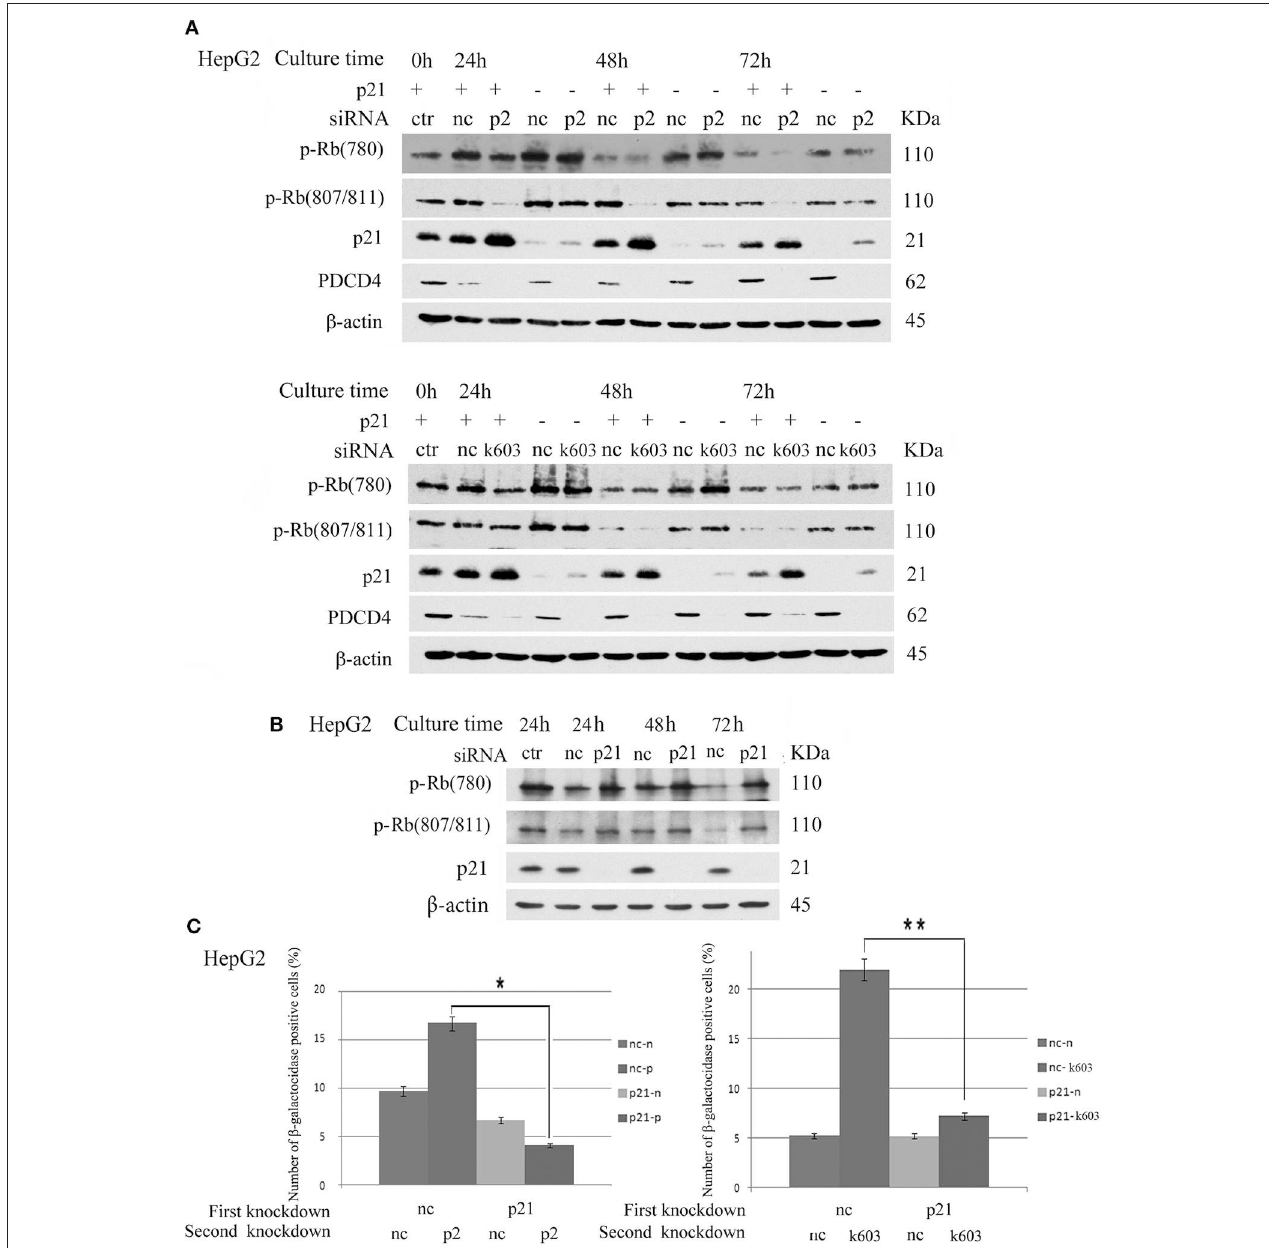
FIGURE 8 | p21 knockdown rescued the down-regulation of Rb phosphorylation and replicative senescence induced by PDCD4 knockdown. (A) p21 knockdown suppressed the down-regulation of Rb phosphorylation induced by PDCD4 knockdown. HepG2 cells were first treated with negative control siRNA (nc) or p21-specific siRNA (p21). After culturing for 24h, each cell sample was then treated with negative control siRNA (nc), PDCD4-specific p2 siRNA (p2, Upper) or k603 siRNA (k603, Lower). The cells were then cultured for a further 24, 48, or 72h and then subjected to a Western blotting analysis using anti-p-Rb (780), anti-p-Rb (807/811), anti-p21, anti-PDCD4 and anti- β -actin antibodies. (B) p21 knockdown up-regulated Rb-phosphorylation. HepG2 cells were treated with negative control siRNA (nc) or p21-specific siRNA (p21) and subjected to a Western blotting analysis with anti-p-Rb (780), anti-p-Rb (807/811), anti-p21 and anti- β -actin antibodies after culturing for the times indicated in the figures. (C) p21 knockdown suppressed the PDCD4 knockdown-induced replicative senescence. (Left panel) HepG2 cells were first treated with negative control siRNA (nc) or p21-specific siRNA (p21). After culturing for 24h, both the nc and p21 knockdown cells were again treated with either negative control siRNA (nc-nc and p21-nc) or PDCD4-specific p2 siRNA (nc-p2 and p21-p2). (Right panel) HepG2 cells were treated the same as in the left panel using PDCD4-specific k603 siRNA. The cells were then fixed and stained with the β -galactosidase assay kit after culturing for an additional 96h. The galactosidase-positive cell numbers represent the average cell number of three different fields. Thousands of cells were counted in each field. The experiments were repeated twice, and similar results were obtained each time. t -test: * p < 0.05; ** p < 0.005.